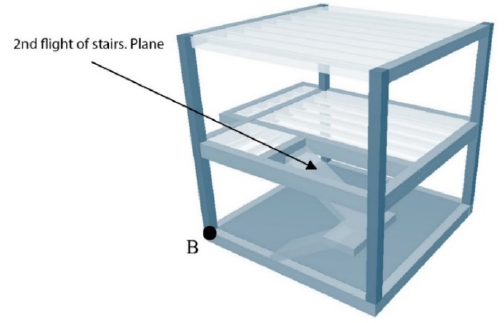
Figure 11. Model sketch IV. Figure 9. Model sketch IV.